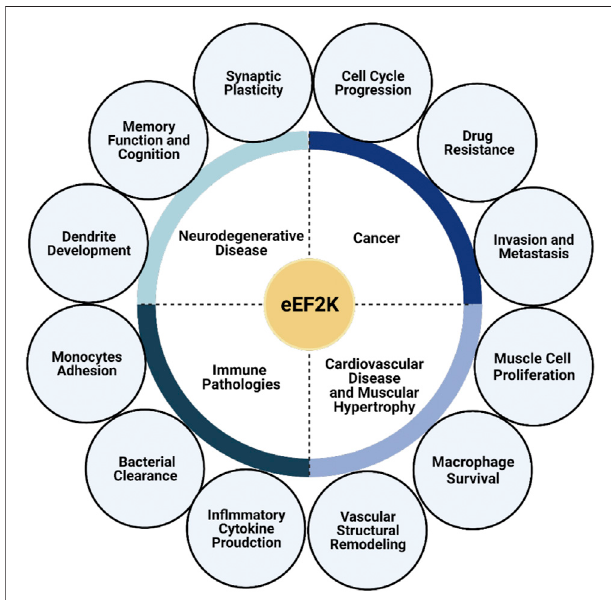
FIGURE3| eEF2K playsasigni fi cantroleinmultiple pathologies. eEF2K is expressed at high levels in several diseases, including neurodegenerative diseases, cancer, cardiovascular disease, muscular hypertrophy, and other immunepathologies,causingittoserveasasuitableandpromisingdrug target. eEF2K affects synaptic plasticity, memory function, and dendrite development in neurology. Dysfunction of these traits leads to the development and progression of neurodegenerative diseases. The progression of cancer and cancer-cell growth has also been correlated with eEF2K activity and expression